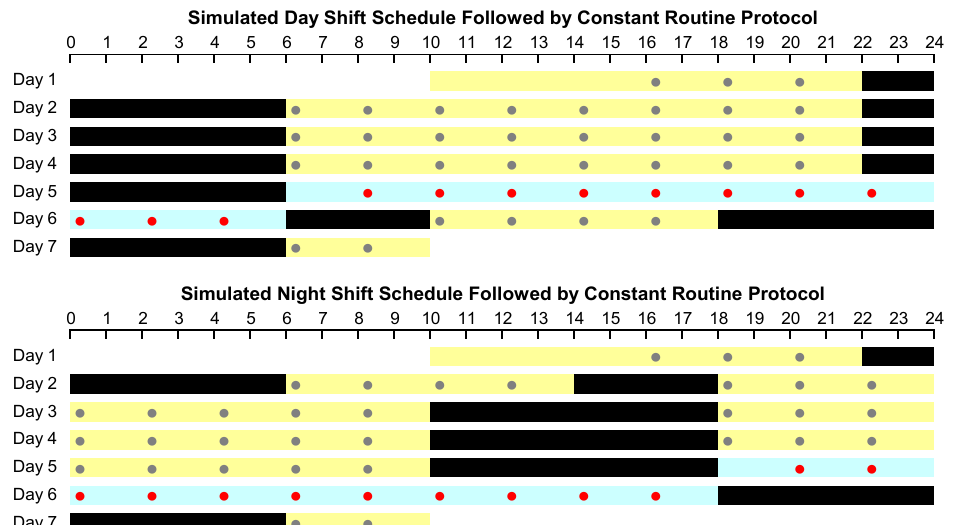
Figure 1. Schematic of the study design, showing the simulated day shift condition ( top ) and the simulated night shift condition ( bottom ). In each panel, time of day progresses from left to right, and days progress from top to bottom. Black bars indicate sleep opportunities; yellow bars indicate scheduled wakefulness. The 24 h waking period of the constant routine (CR) protocol that followed three days of simulated day or night shift schedule is shown in blue. Dots denote neurobehavioral test bouts; red dots indicate the test bouts used for analysis.